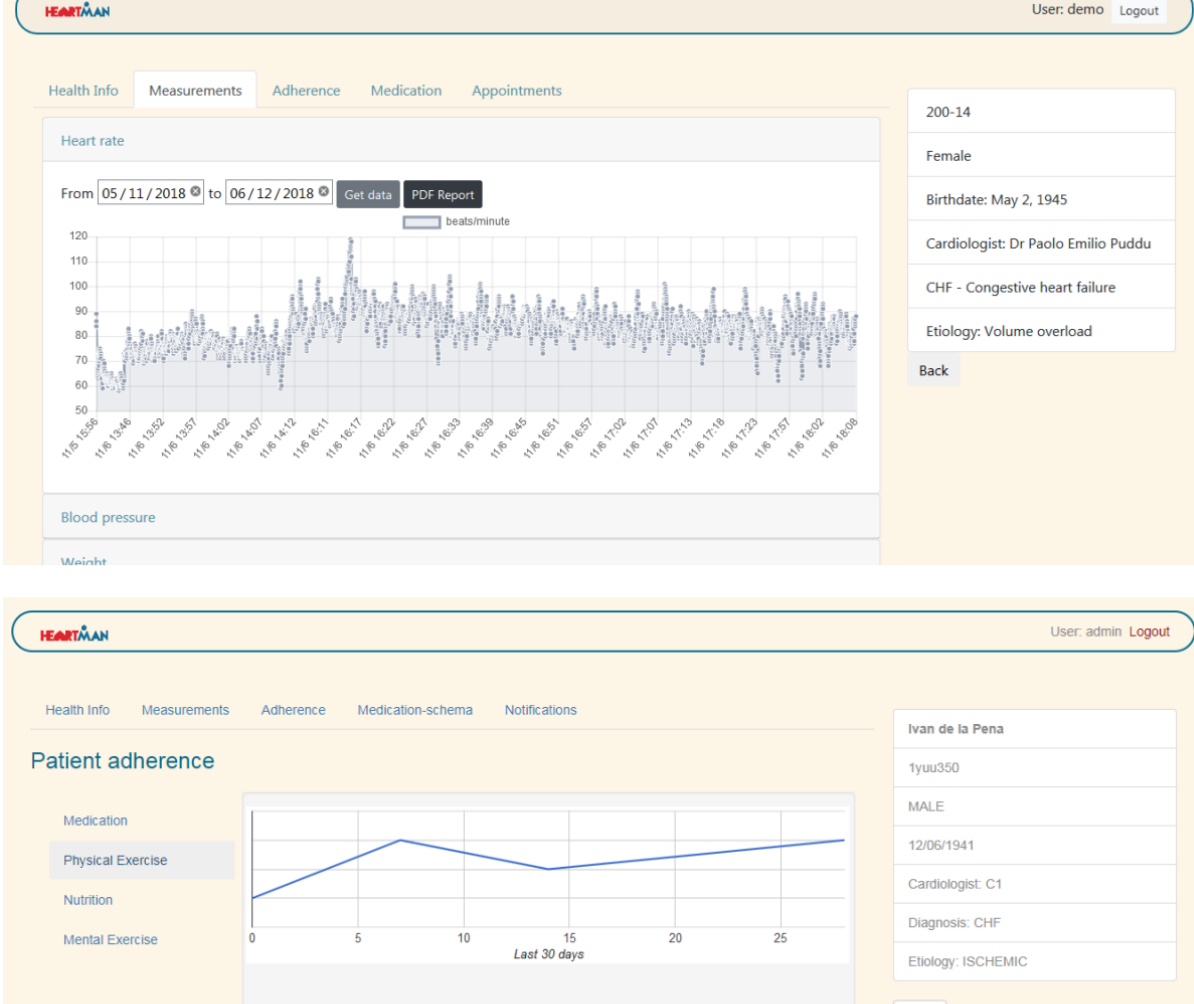
Figure 6. Screenshots of the HeartMan web application for medical professionals: heart rate measurements (upper) and adherence to the HeartMan-suggested self-management